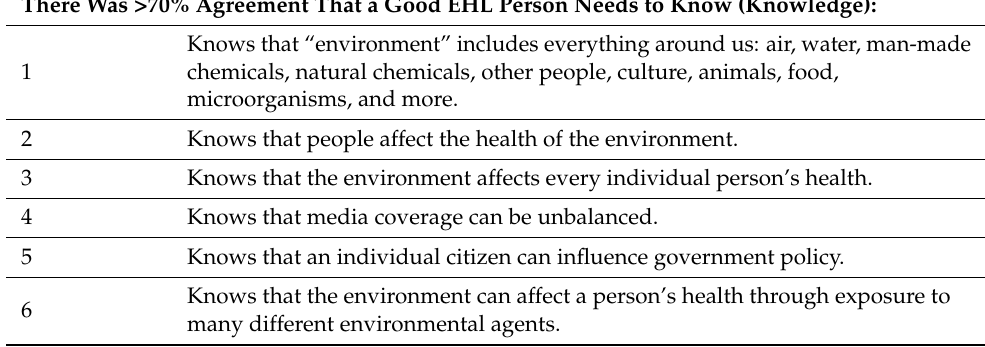
Table 3. Knowledge Items chosen for the EHL